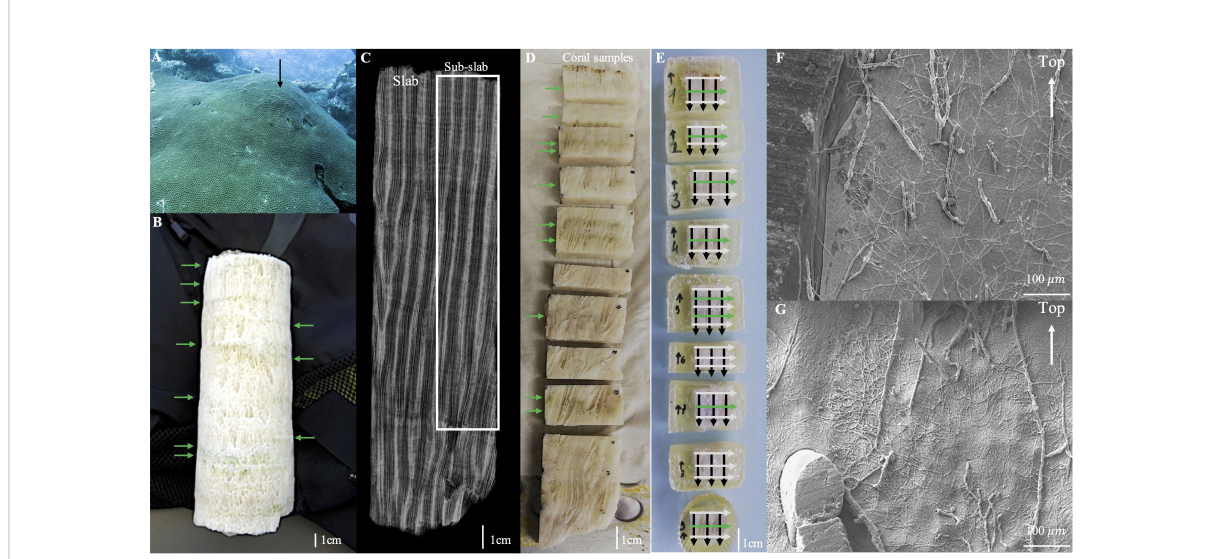
FIGURE 2 Studied Diploastrea coral colony at Mayotte. (A) Diploastrea colony at 15 m depth. The black arrow indicates where the colony was sampled. (B) Diploastrea core with visible green bands (green arrows). (C) X-ray radiograph of one middle slab cut out of the Diploastrea core measuring 19.5 cm long showing the annual density banding pattern. The studied area is indicated by the white rectangle. (D) Ten samples were cut from the radiographed slab of Diploastrea core. Only the fi rst nine samples from the top were analyzed to estimate the microborer traces ’ abundance. Green arrows indicate green bands. (E) Resin impregnation of the 9 samples. Horizontal white and green arrows represent the horizontal transects where measurements of microborings abundance were realized (i.e. within white vs green bands). The black arrows represent the vertical transects studied in each sub-sample. (F, G) Different resin casts of microborings observed under scanning electron microscope after resin impregnation of coral samples and partial decalci fi